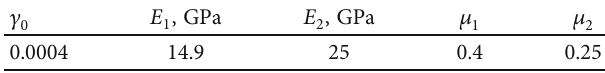
Table 5: The parameters of [10, 11].